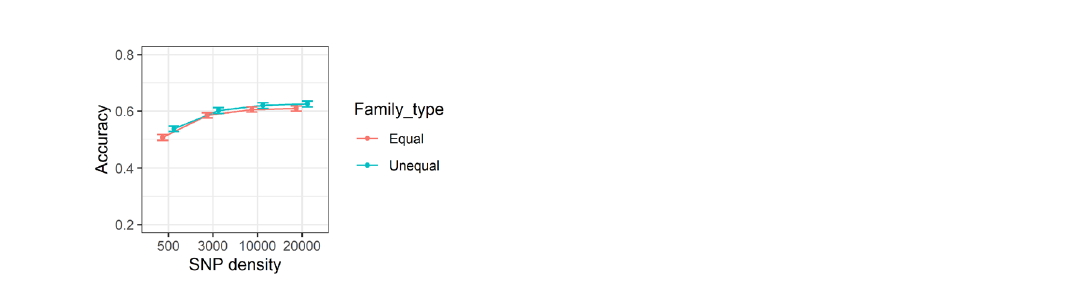
Figure 6. Accuracy of genomic estimated breeding values over marker densities of 0.5, 10 and 20 K for equal versus unequal family contribution. Correlations are averaged over different generations, replicates, genotypic error rates and heritability. Standard errors of accuracies are shown as error